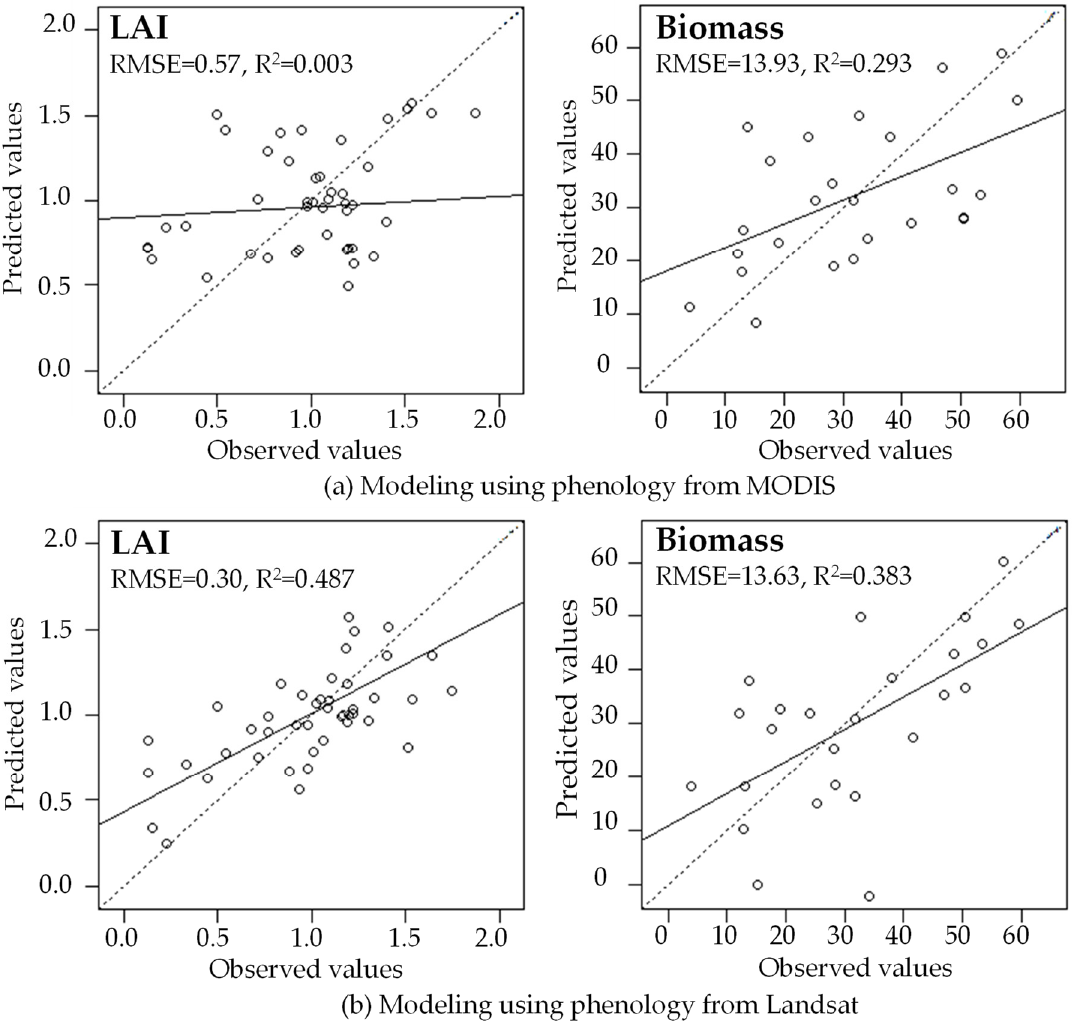
Figure 12. Leave-one-out validation results from modeling LAI and biomass using phenology metrics derived from a MODIS time series ( a ) and a reconstructed Landsat time series ( b ) in the tropical dry forest of Mona Island, Puerto Rico.